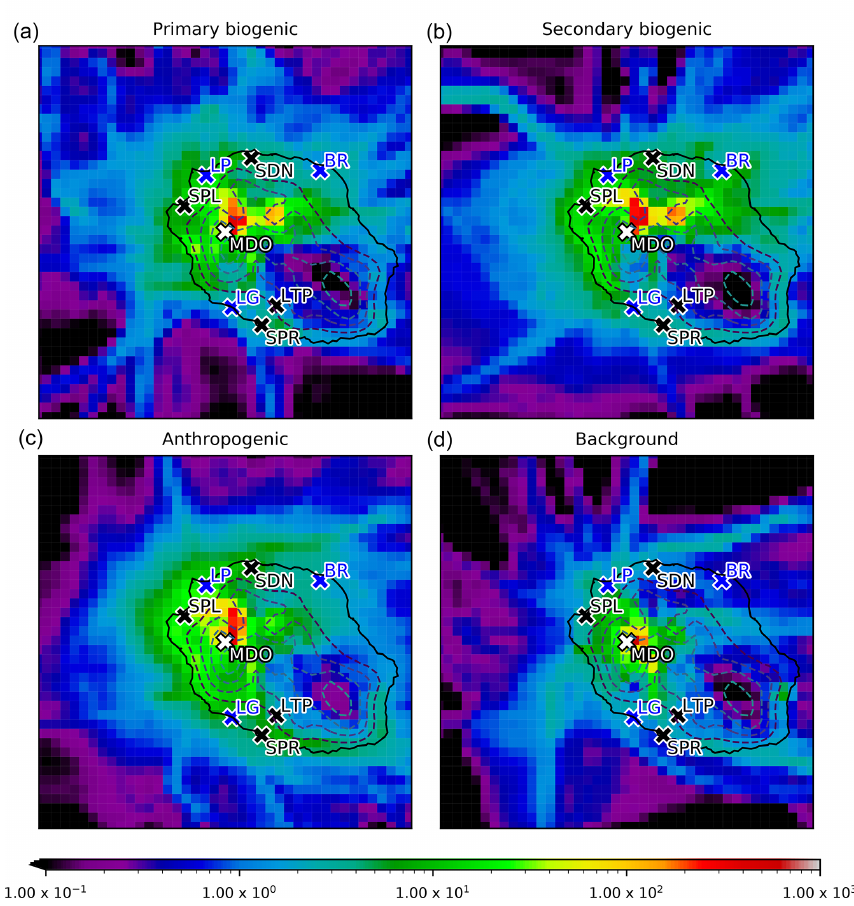
Figure 17. The spatial distribution of SRRs (sm − 1 ) over La Réunion for the top 5% source factor contributions calculated by the PMF algorithm for the primary biogenic (a) , secondary biogenic (b) , anthropogenic (c) , and background (d) sources. The Maïdo observatory (MDO) is indicated in white. Cities with population of over 50000 habitants – i.e., Saint-Denis (SDN), Saint-Paul (SPL), Le Tampon (LTP), and Saint-Pierre (SPR) – are shown in black. The largest industrial sites – Le Port (LP), Bois-Rouge (BR), and Le Gol (LG) – are indicated in blue. Dashed lines are surface elevation contours in the FLEXPART-AROME model separated by